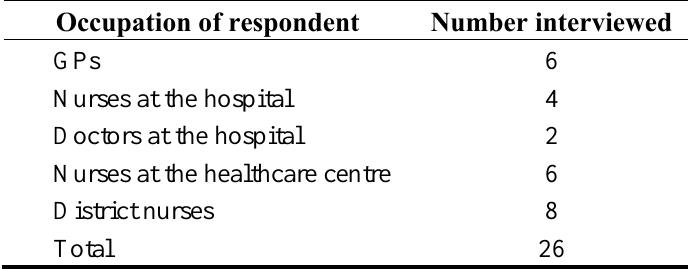
Table 2. Occupations of healthcare professionals